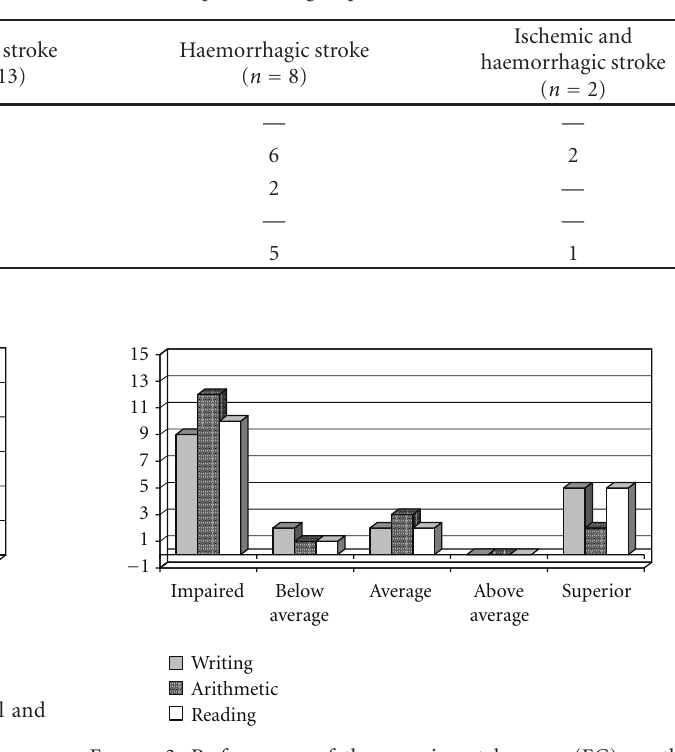
Figure 3: Performance of the experimental group (EG) on the writing, arithmetic, and reading test.